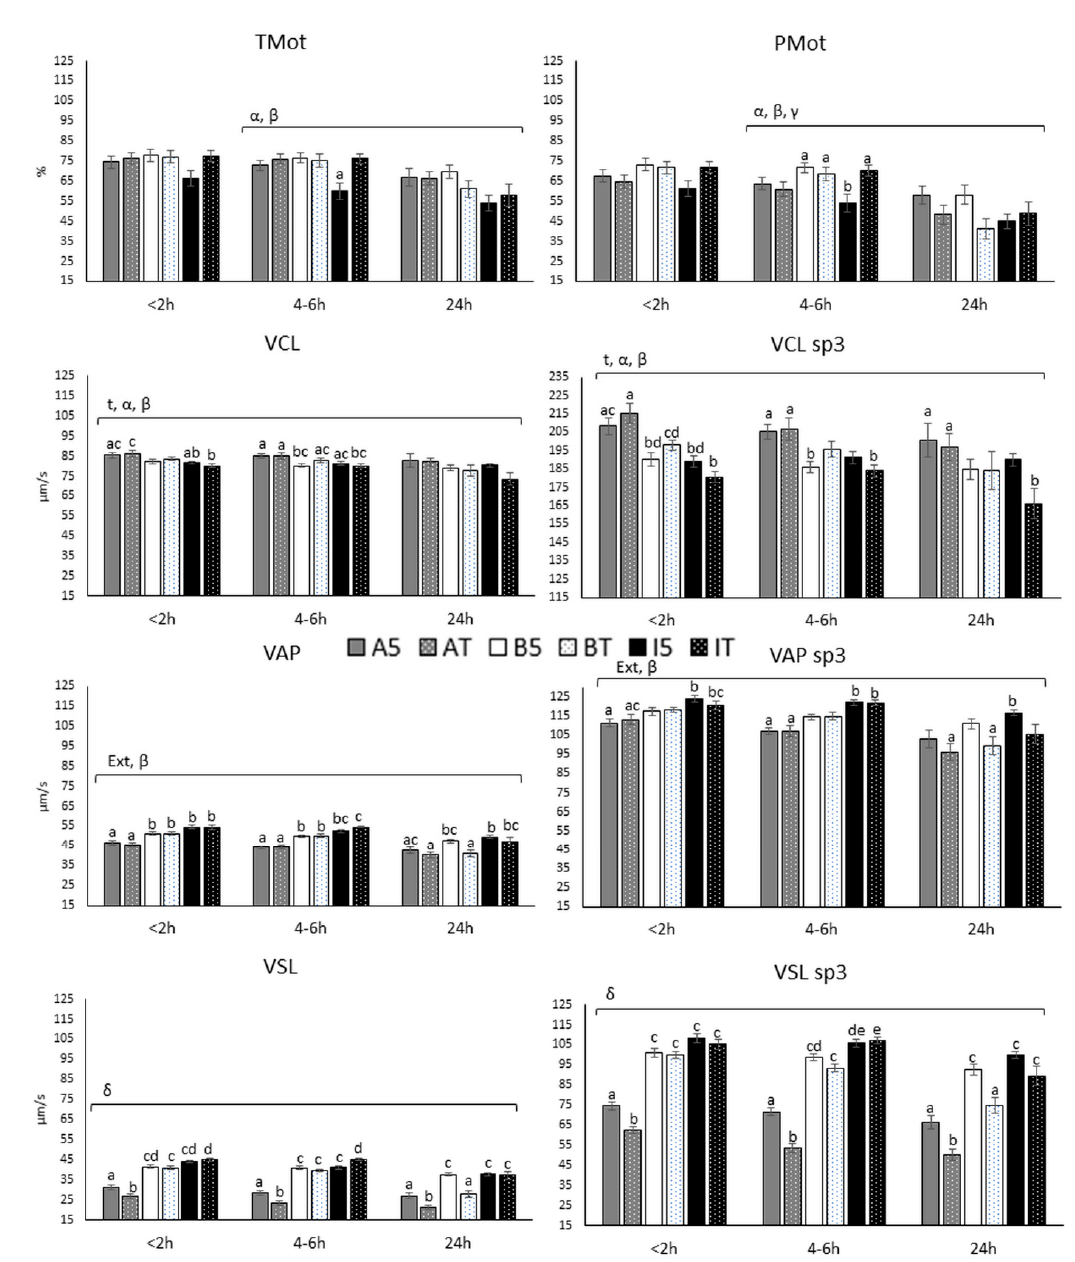
Figure 3. Average bull sperm CASA kinematic motility and velocity parameters of all subpopulations and specifically sp3 subpopulation, at three different time-windows until assessment (<2, 4–6 and 24 h), with three different extenders (AndroMed ® , BIOXcell ® and INRA96 ® ) and at two holding temperatures (refrigeration vs. room temperature). Bars with different letters mean statistical significantly different values ( p < 0.05) among the six combinations extender by holding temperature, at each time window (ANOVA analyses). Square brackets over the bars highlight statistically significant effects ( p < 0.05; from GLM analyses) of the factors or factors’ interactions (Greek letters), during the time-windows embraced. Abbreviations: CASA: Computer Assisted Semen Analyses; TMot: total motility; PMot: progressive motility; VCL (curvilinear velocity, µ m/s); VAP (average path velocity, µ m/s); VSL (straight velocity, µ m/s); sp3: fast subpopulation. A: AndroMed ® ; B: BIOXcell ® ; I: INRA96 ® ; T: room temperature; 5: refrigeration at 5 ◦ C. < 2h: time of assessment <2 h after collection; 4–6 h: time of assessment 4–6 h after collection; 24 h: time of assessment 24 h after collection; α : interaction temperature by extender; β : interaction temperature by time; γ : interaction extender by time; δ : interaction temperature by extender by